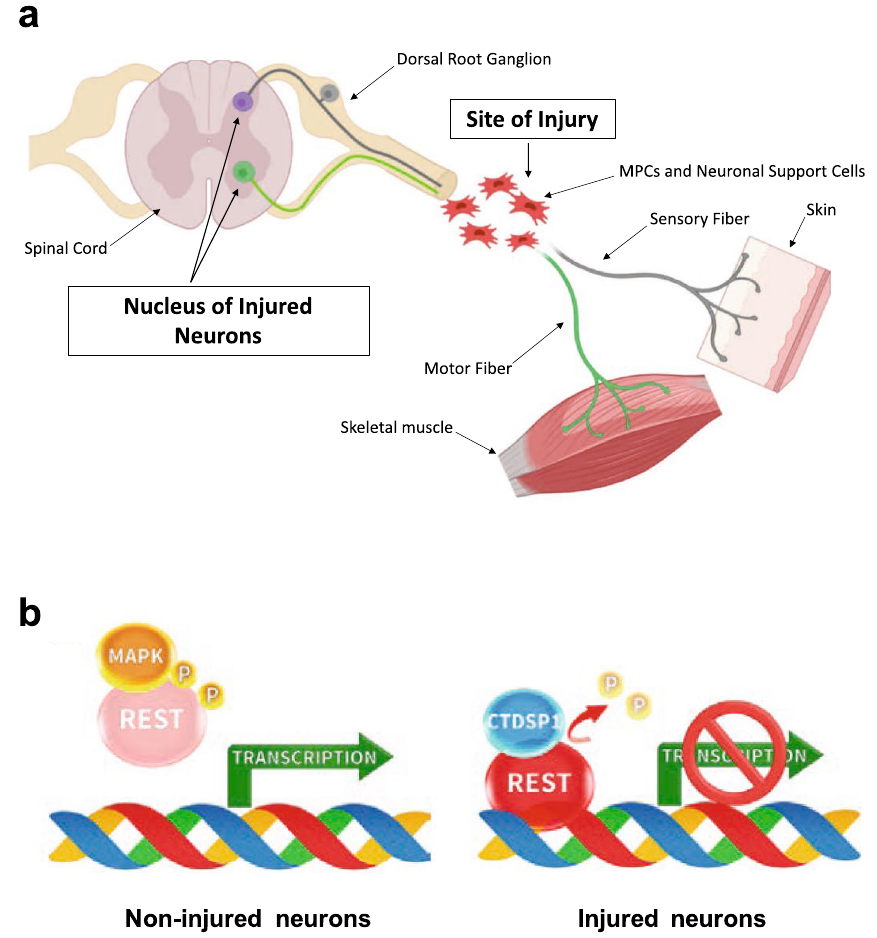
Figure 1. Injury model and REST-CTDSP1 regulation of neuronal gene transcription. ( a ) Schematic illustrating our working hypothesis. After musculoskeletal injury, MPCs and other support cells (shown in red) accumulate at the site of injury. We propose to promote axonal regeneration and support axonal growth by modulating REST levels both in the nucleus of supporting cells at the site of injury and in the nucleus of injured neurons. ( b) Left panel: In non-injured neurons, phosphorylation of REST by a MAP kinase (MAPK) leads to detachment of REST from the chromatin and expression of neuron-specific genes. Right panel: After